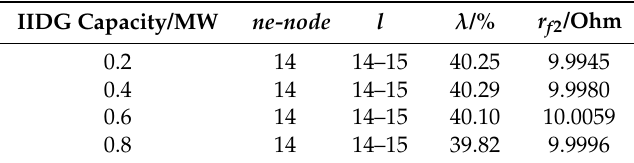
Table 7. Locating results of Strategy 1 with different capacities of IIDG.